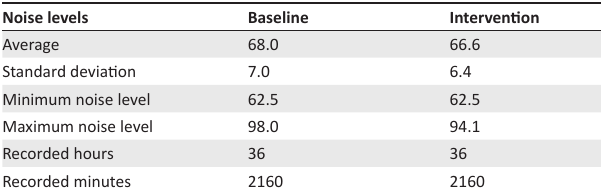
TABLE 2: Noise levels (dBA) for the baseline and intervention phase. TABLE 3: Thematic analysis of teacher perceptions of the visual feedback